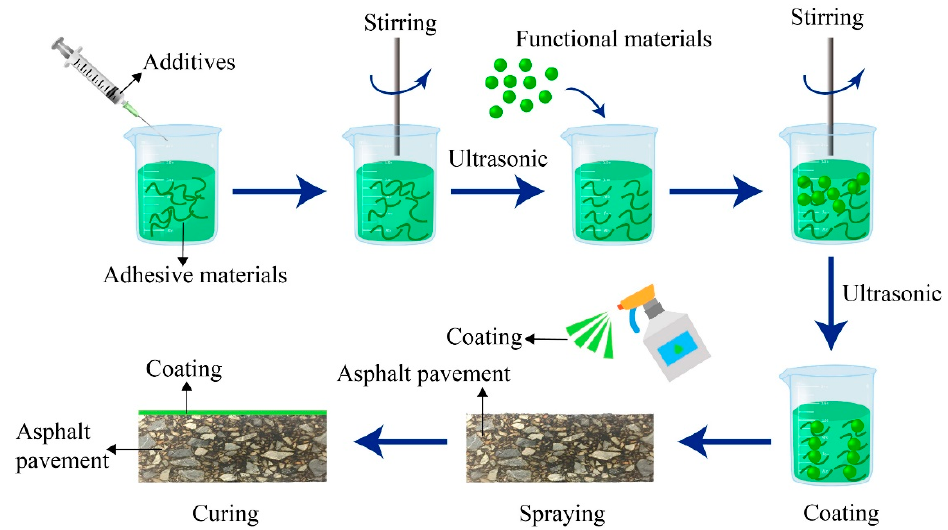
Figure 3. Schematic of the coating preparation process.